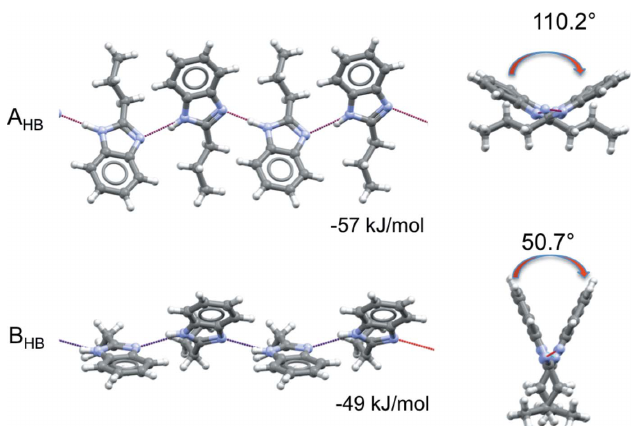
Figure 7 Type A (top) and type B (bottom) hydrogen-bonded chains in 2PrBzm. Perpendicular (left) and parallel (right) views of the hydrogen-bonded chain direction.